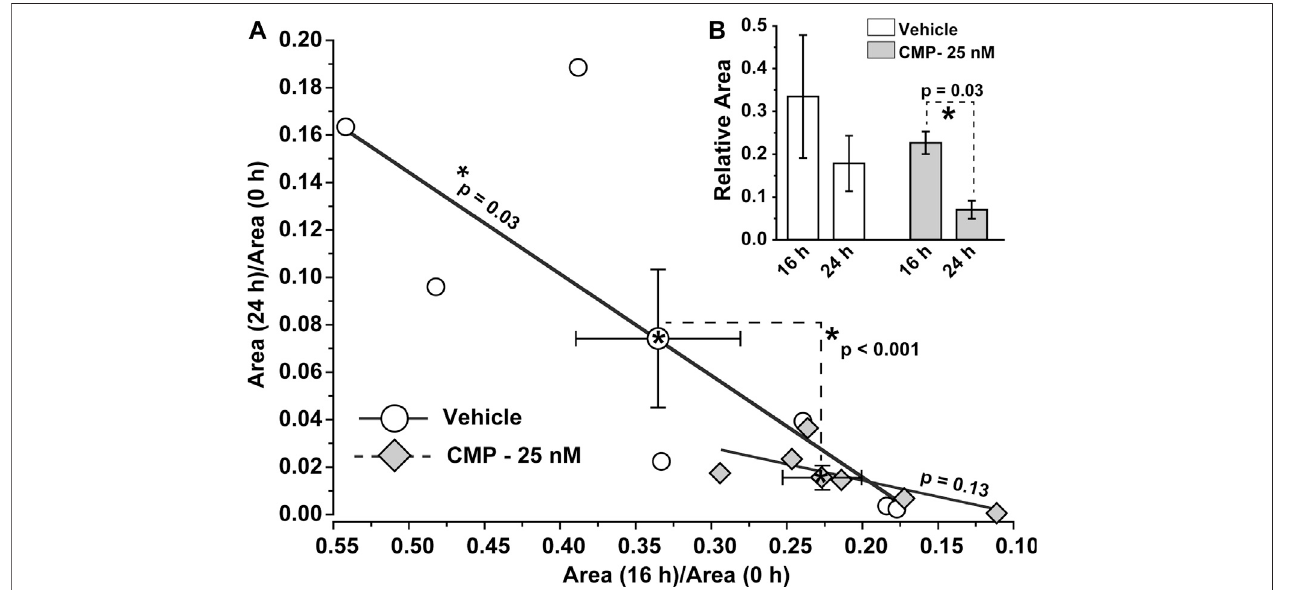
FIGURE3| CMPacceleratestherateofepitheliumwoundclosure. (A) Forvehicle-treatedeyes,theratioofresidualwoundareaat24 htoinitial(0 h)sizedecreases with a diminishing ratio of the area at 16 h to initial. The slope of the best- fi tting regression line differs signi fi cantly from 0 (*, p (cid:2) 0.03). For CMP-treated eyes (25 nM), accelerated closure clusters both ratios at smaller values, yielding an insigni fi cant regression ( p (cid:2) 0.13). The cluster of ratios for a vehicle vs. CMP cohorts differed signi fi cantly(dashedlines, p < 0.001),asshownbymultivariableanalysisofvariancetocomparethemeans(mean ± SEM)( B ,inset).Relativewoundsizecalculated as the ratio of residual wound area at 16 h to initial and at 24 compared to 16 h for vehicle- and CMP-treated eyes (mean ± SEM). Wound area diminished signi fi cantly between 24 and 16 h compared to the initial 16 h period for CMP eyes ( p (cid:2) 0.03) but not for a vehicle ( p (cid:2) 0.10). Importantly, initial wound size for CMP-treated eyes (1.41 ± 0.13 mm) did not differ from vehicle-treated eyes (1.54 ± 0.17 mm, p (cid:2) 0.38; n (cid:2) 7 for each